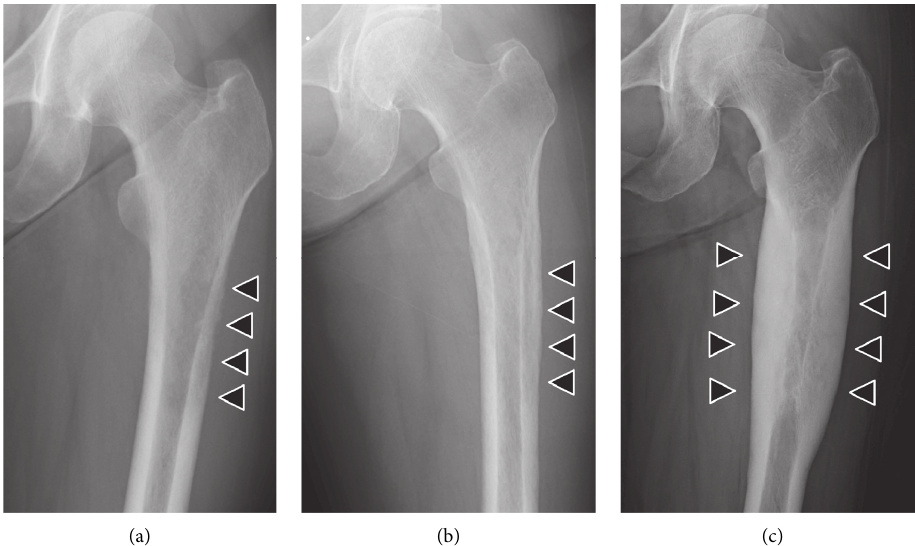
Figure 3: X-ray findings of the left femur at different timepoints showing the radiologic change of a purely osteolytic lesion to an osteosclerotic lesion over time (arrowhead). (a) At first visit, (b) at 3 months after the first visit, and (c) at 15 months after the first